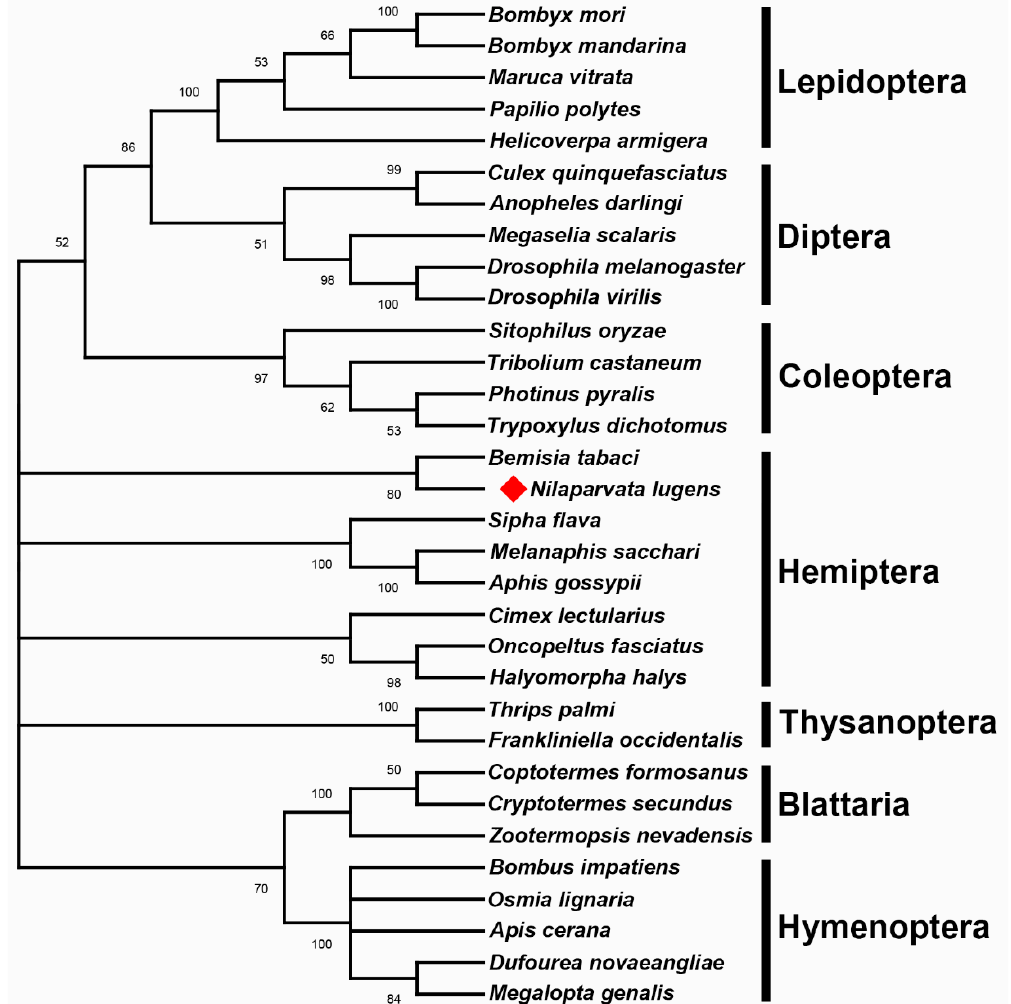
Figure 2. Phylogenetic analysis of the IX homologs. The phylogenetic tree was constructed based on IX proteins from 32 species using the neighbor-joining algorithm. Bootstrap values are shown at the nodes, whereas the NlIX is shown with a red rhombus.